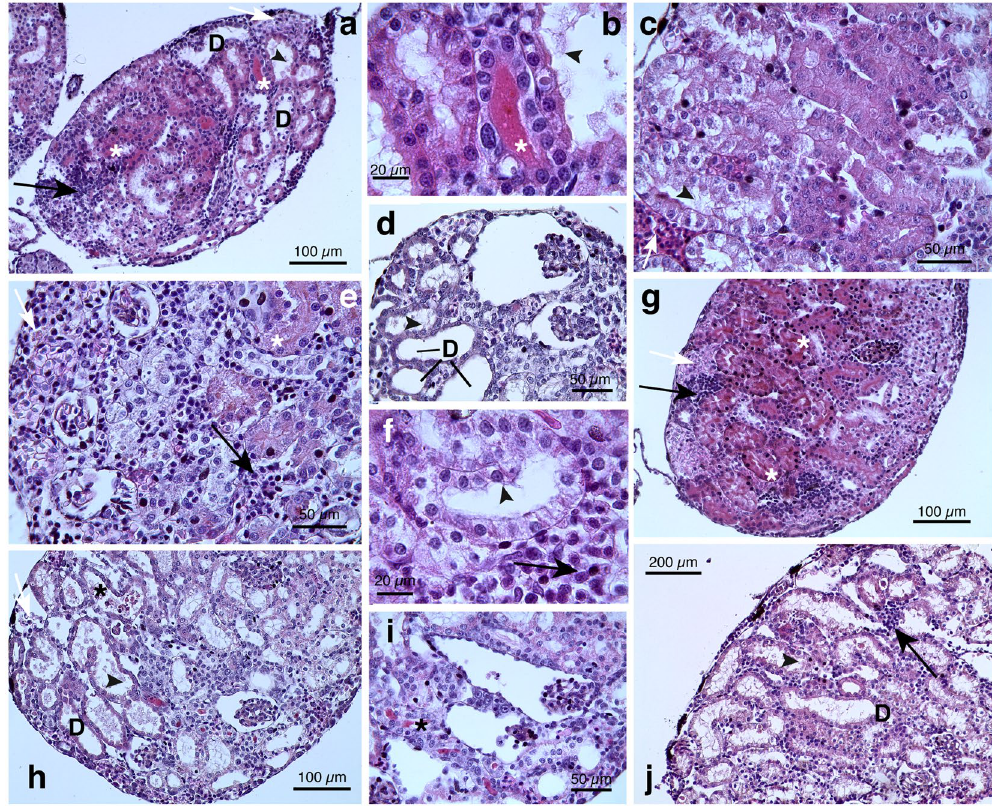
Figure 5. Histopathological examination of kidney tissue in H . intermedia juveniles after chronic exposure to pyrimethanil. Representative light micrographs showing marked kidney impairments in H . intermedia after exposure to 5 µ g/L ( a – f ) and 50 µ g/L ( h – j ) of pyrimethanil. Extensive signs of tubular degeneration are detected including: ( a , d , h , j ) renal tubular dilation (D); ( b , f ) destruction of brush border (arrowheads) clearly appreciable at higher magnification; ( b , c , e , f , h – j ) diffuse loss of the integrity of the cells, hydropic swelling, vacuolization and apoptotic cells. ( a , b , g – i ) The renal tubules contain intraluminar proteinaceous deposits ( * ) that appear as dark pink eosinophilic material. (d , e , h – j ) Considerable glomerular shrinkage and enlargement of Bowman’s capsula can be observed. ( a , c , e – h , j ) Inflammatory phenomena are frequently detected: infiltration of inflammatory cells, mainly mononuclear cells (black arrows); haemorrhage (white arrows). All cross-sections are